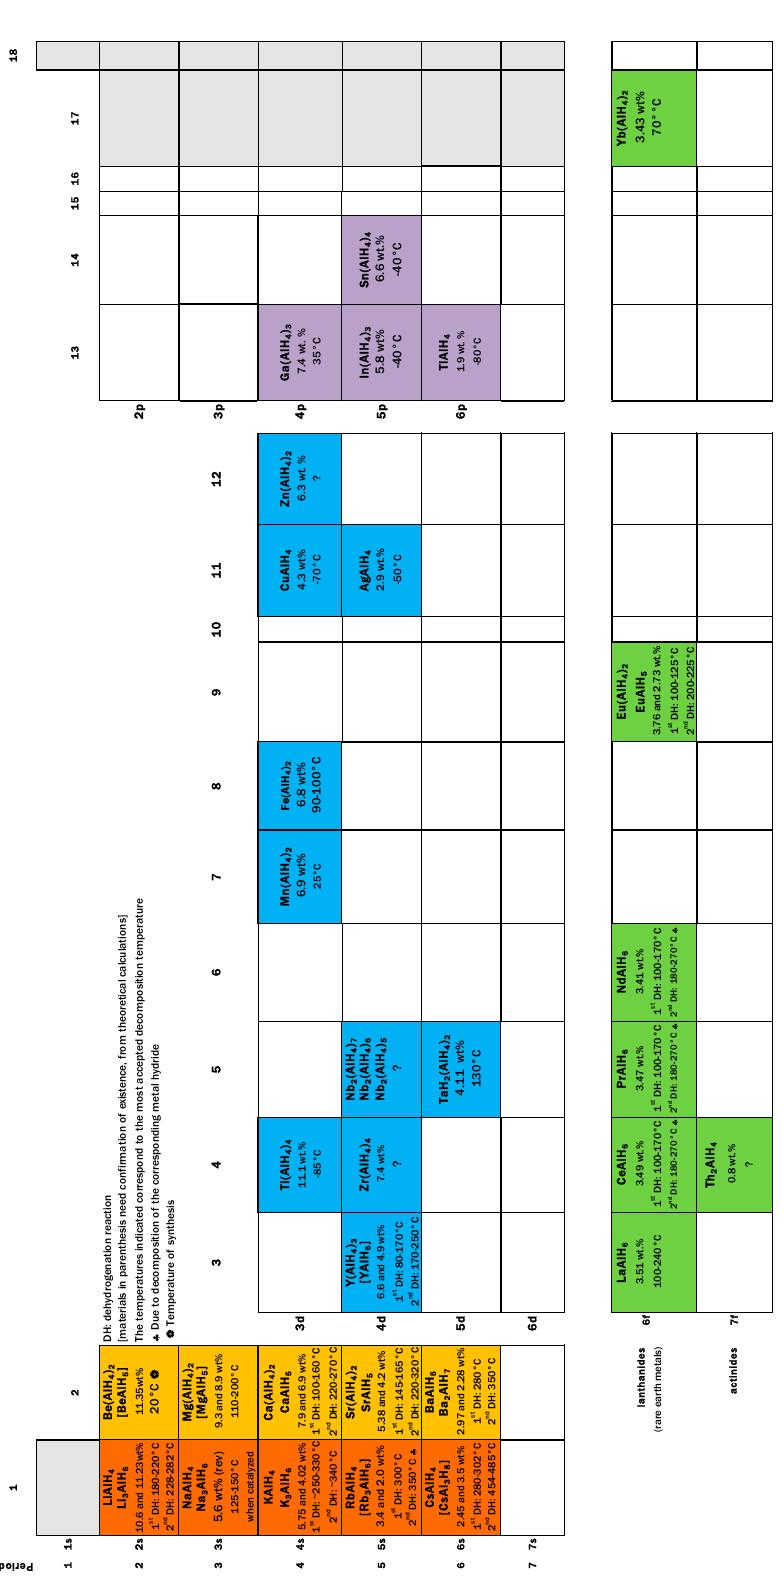
Figure 1. Periodic table of alanates. The reported alanates were collected in this “periodic table”.